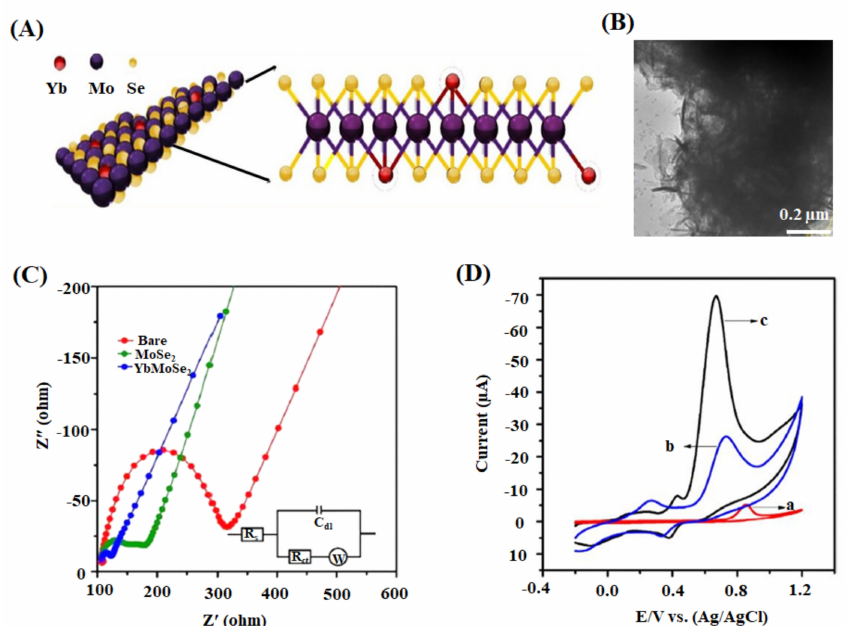
Figure 7. ( A ) Schematic of the proposed molecular packing structure and ( B ) HRTEM image of YbMoSe 2 . ( C ) Nyquist plot demonstrating the electrochemical performance of bare, MoSe 2 , and YbMoSe 2 glassy carbon electrodes in 5 mM ferricyanide system in 0.1 M of KCl. The inset shows an equivalent circuit model (R ct —charge transfer resistance; C dl —double-layer capacitance; R s —solution resistance; W—Warburg impedance). ( D ) CV of bare GCE (a), MoSe 2 /GCE (b), and YbMoSe 2 /GCE (c) with 0.29 mM diphenylamine in N 2 purged buffer at 50 mV s − 1